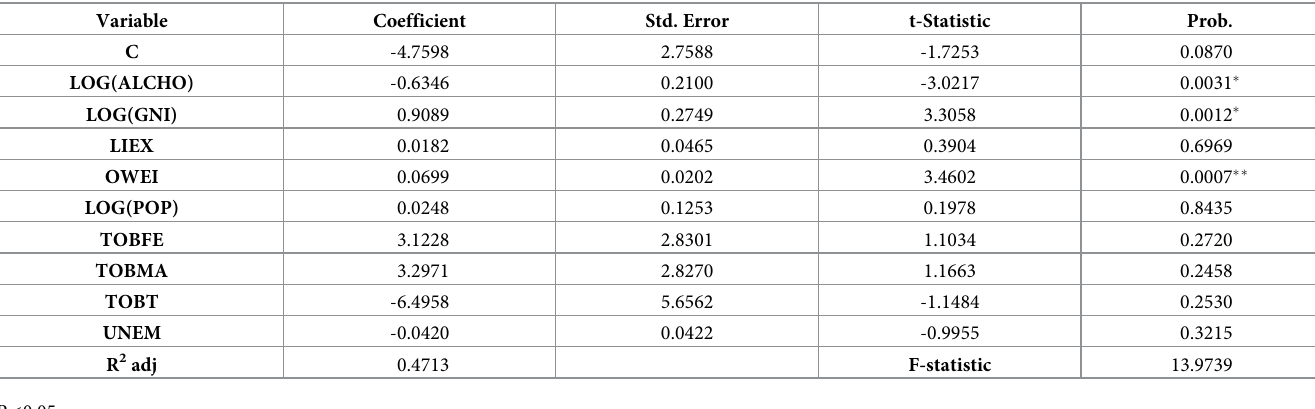
Table 4. Model 1 regression results for unrestricted